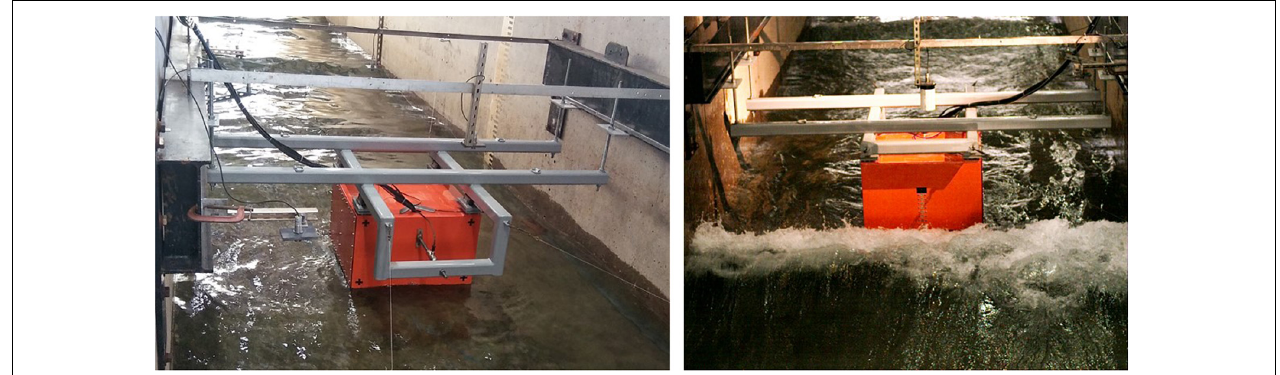
FIGURE 5 | Lee-side of the specimen (left) and wave impacting elevated structure (right) .